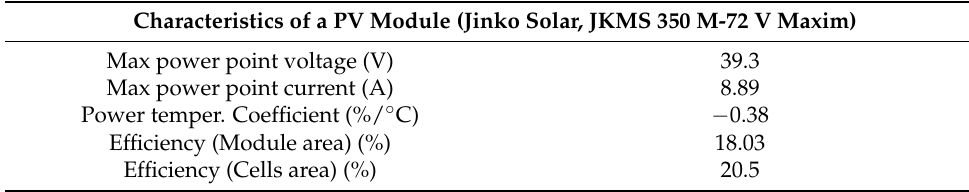
Table 4. Performance parameters of monocrystalline silicon photovoltaic